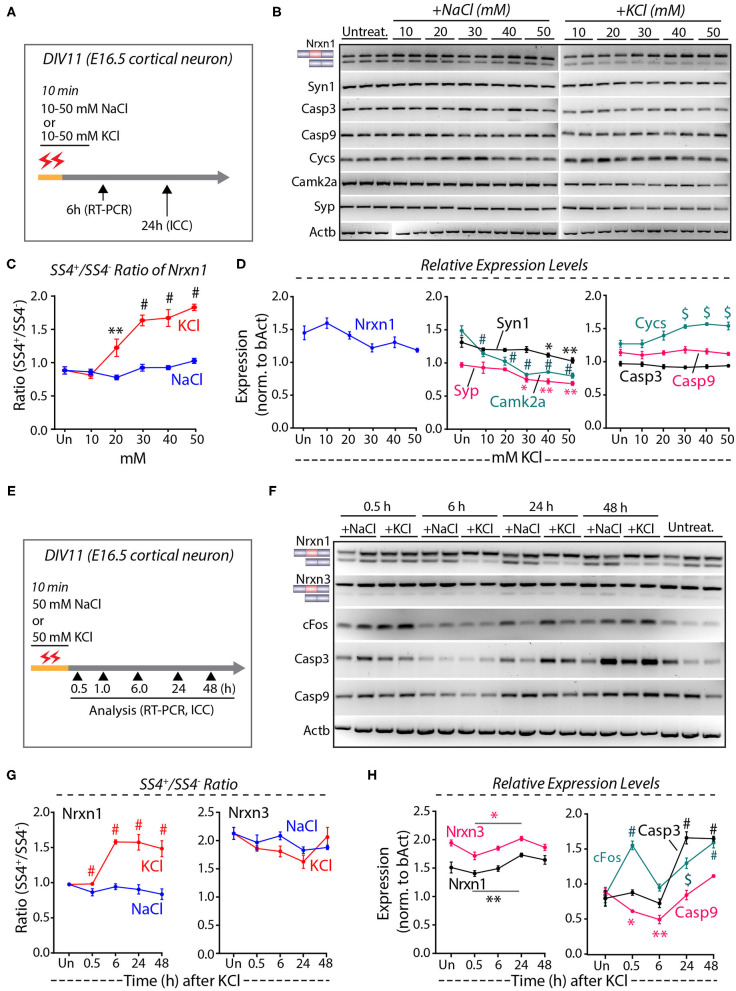
High KCl exposure in cultured cortical neurons leads to reduction in synaptic gene expression and obscures Nrxn1 SS4+/– ratio. (A) Experimental paradigm where DIV11 cortical neurons isolated from E16.5 mouse embryos were treated with 10–50 mM NaCl or KCl for 10 min and harvested at 6 and 24 h for RT-PCR and ICC analysis, respectively. (B) RT-PCR shows Nrxn1-SS4 alternative splicing and expression of genes encoding key synaptic proteins and cell death markers in untreated and cultures treated with 10–50 mM NaCl or KCl. (C) Quantification of Nrxn1 SS4 splicing ratio showing significant difference with increasing KCl concentration compared to NaCl (* = p 0.0055, # = p < 0.0001). (D) Relative expression levels of total Nrxn1, synaptic markers Syn1, Syp, and Camk2a (note the significant downregulation upon different KCl concentrations), cell death markers Cycs, Casp3, and Casp9 (note the significant upregulation of Cycs upon different KCl concentrations) [Syn1: * = p 0.0457, ** = p 0.0015; Camk2a: #
p < 0.0001; Syp: * = P 0.0151, ** = p 0.0042, $ = p 0.0011]; Cys: $ = p 0.0010 (30 mM), p 0.0001 (40 mM) p 0.0006 (50 mM). (E) Experimental paradigm where DIV11 cortical neurons isolated from E16.5 mouse embryos were treated with 50 mM NaCl or KCl for 10 min and harvested at indicated time points for RT-PCR and ICC analysis. (F) RT-PCR analysis shows Nrxn1 and Nrxn3 SS4 alternative splicing and expression of cFos and cell death markers Casp3 and Casp9. (G) Quantification of Nrxn1 and Nrxn3 SS4 ratios show significant difference in Nrxn1 SS4 ratio with time duration after KCl treatment compared to NaCl (# = p < 0.0001). (H) Quantification of relative expression levels of total Nrxn1 and Nrxn3 show increased levels between 0.5 and 24 h (* = p 0.0101, ** = p 0.0059) and cFos levels show significant induction at 0.5 h and decrease to basal levels at 6 h and increase again at 24 and 48 h. Cell death markers Casp3 is upregulated ta 24 and 48 h whereas Casp9 is downregulated initially at 0.5 and 6 h and upregulated at 24 and 48 h. (cFos: # = p < 0.0001, $ = 0.0003; Casp3: # = p < 0.0001; Casp9: *p = 0.0434, **p = 0.0017). All numerical data are represented as means ± SEM. Statistical significance was calculated by two-way ANOVA using Tukey's multiple comparison test.